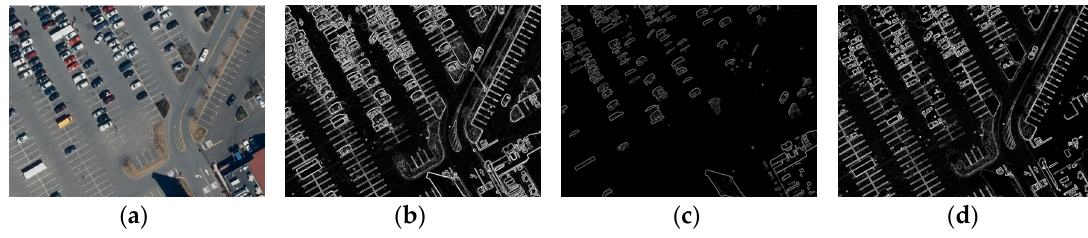
Figure 2. Original image and calculated gradient images. ( a ) Original image; ( b ) gradient of the original image; ( c ) gradient of the image thresholded over 60; ( d ) gradient of the image thresholded under 100.